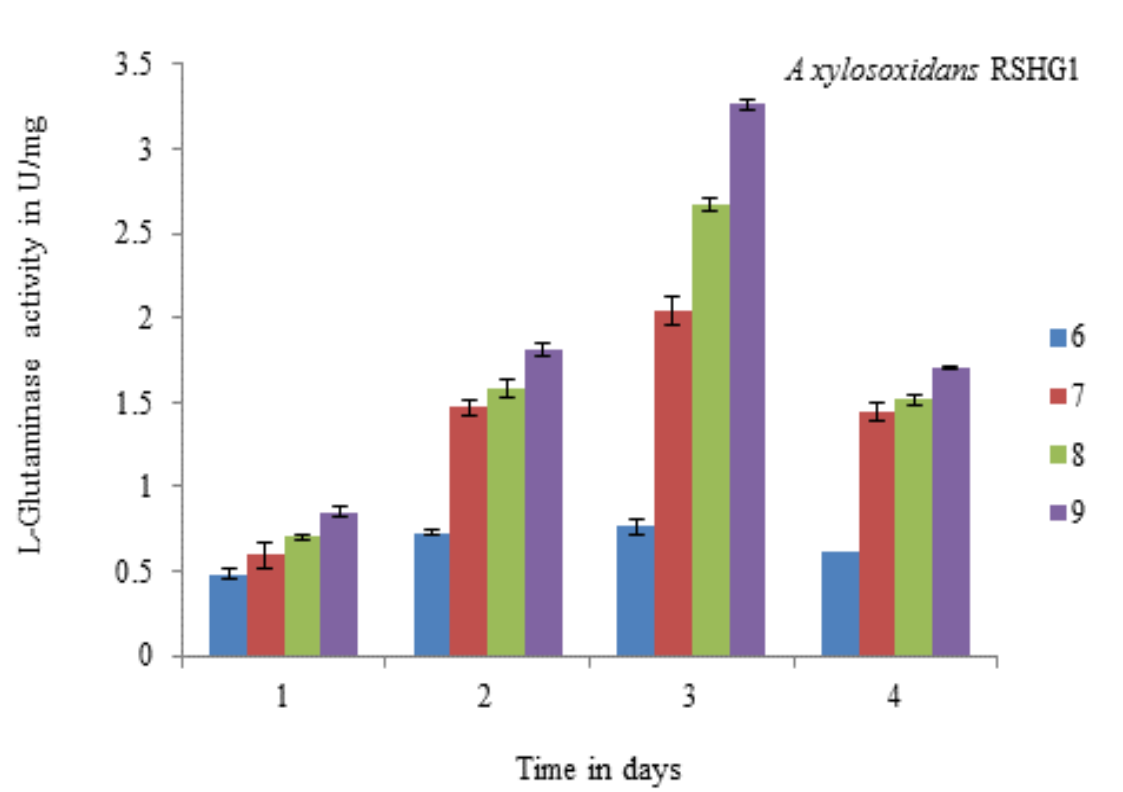
Figure 4. Effect of pH on glutaminase production by A. xylosoxidans RSHG1 on fermentation media at 30 °C.